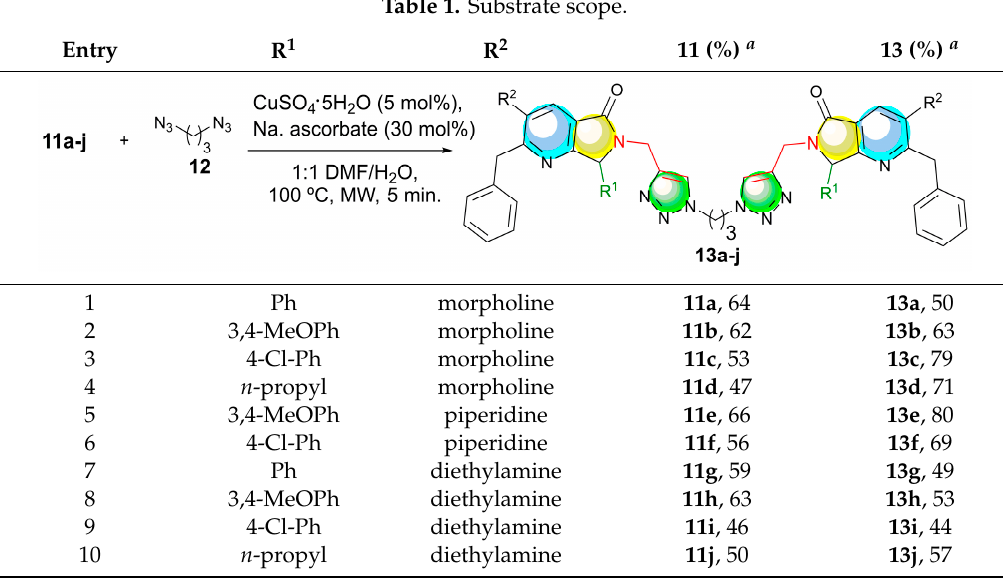
Table 1. Substrate scope.